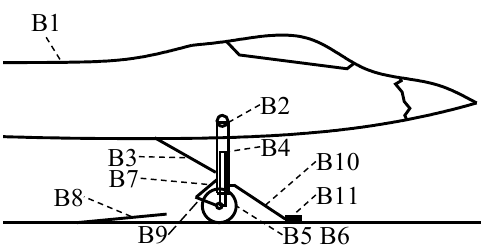
Figure 2. Carrier-based aircraft in the dragging and rolling phase.